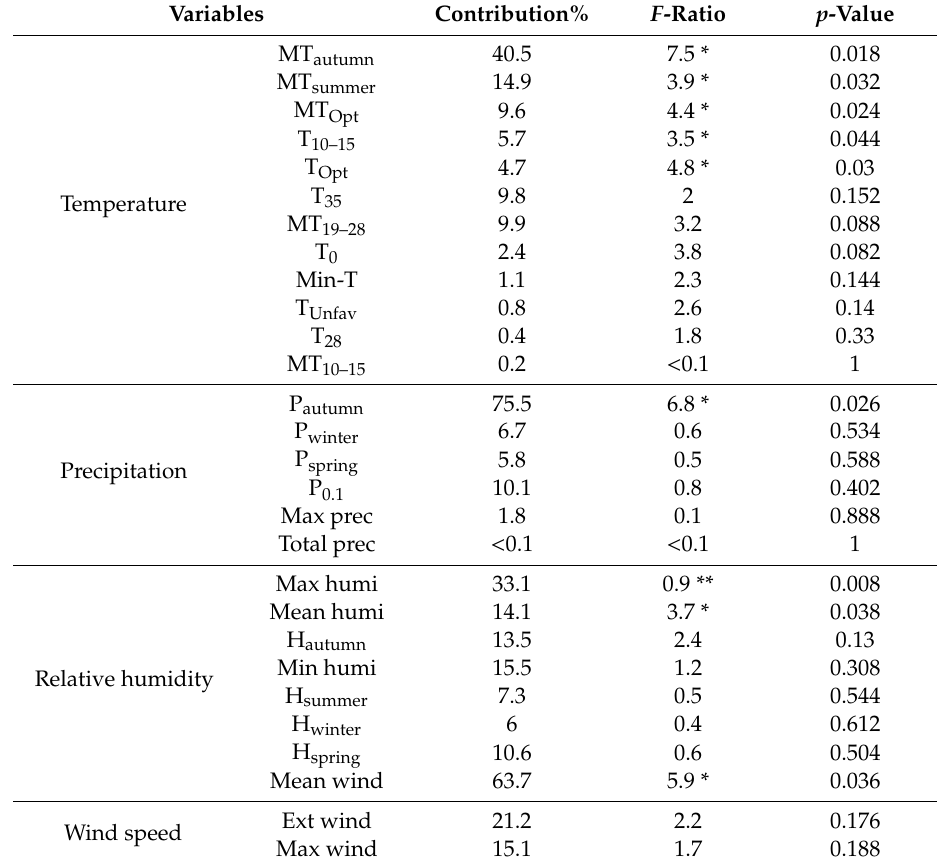
Table 3. The selected climate and weather variables obtained from the summary of forward selection in the redundancy analysis.